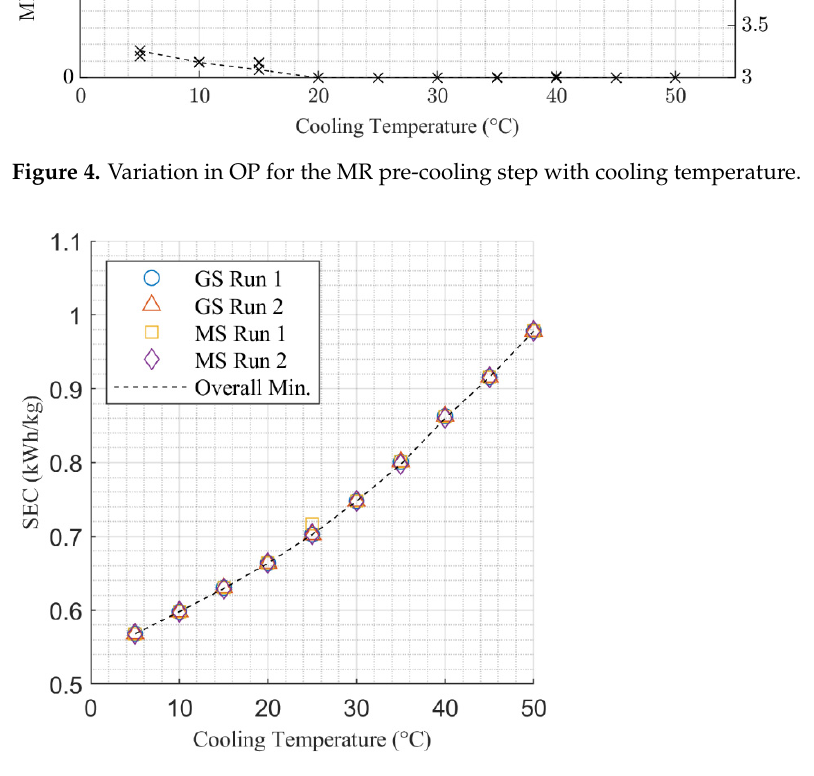
Figure 5. Variation in SEC for the MR pre-cooling step with cooling temperature.